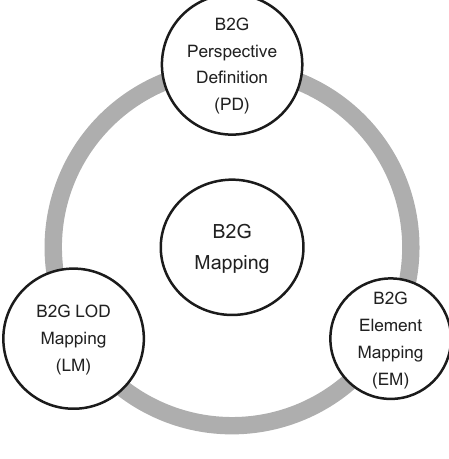
Figure 4. B2GM conceptual overview.